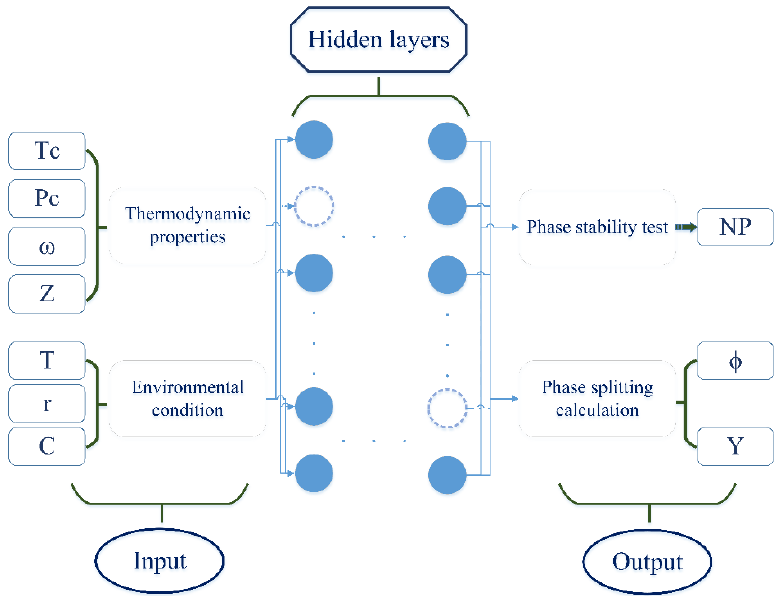
Figure 2. Schematic diagram of the flash neural network considering capillarity.